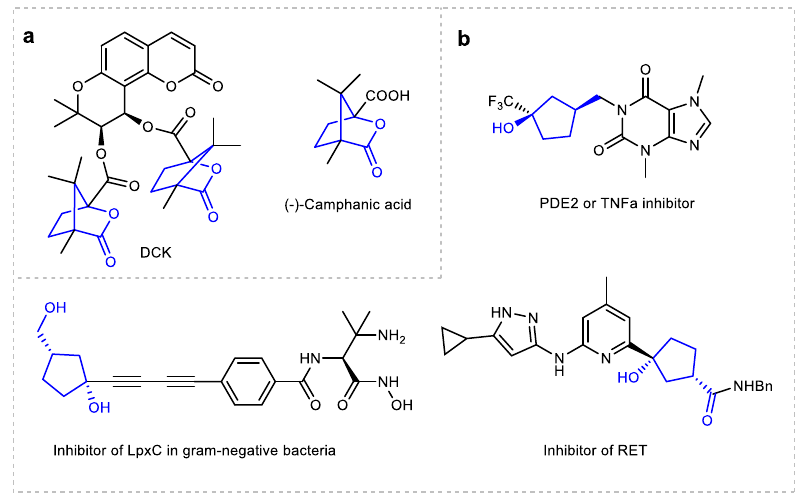
Fig. 1 Pharmaceutics and bioactive compounds containing bridged [2,2,1] bicyclic lactones and their ring-opening derivatives. a Bioactive molecules containing bridged [2,2,1] bicyclic lactones. b Ring-opening derivatives of bridged [2,2,1] bicyclic